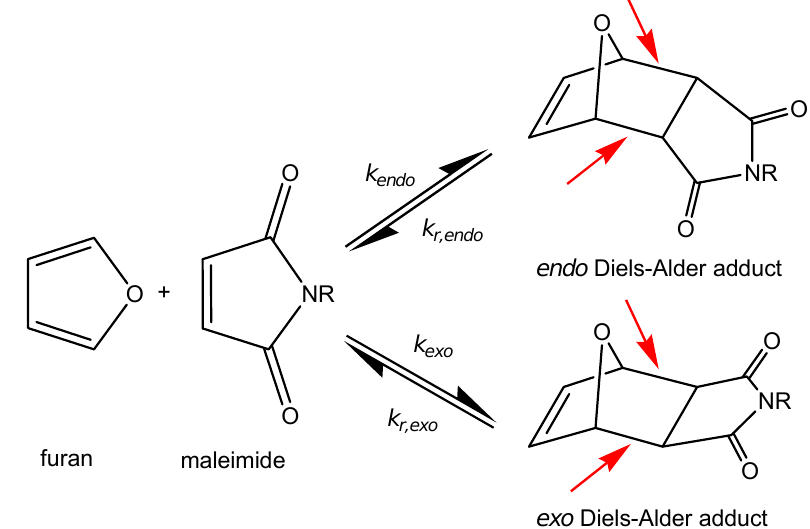
Figure 1. Reversible Diels–Alder reactions between maleimide and furan derivatives, forming endo and exo Diels–Alder adducts. Reversible Diels–Alder bonds are indicated by red arrows.